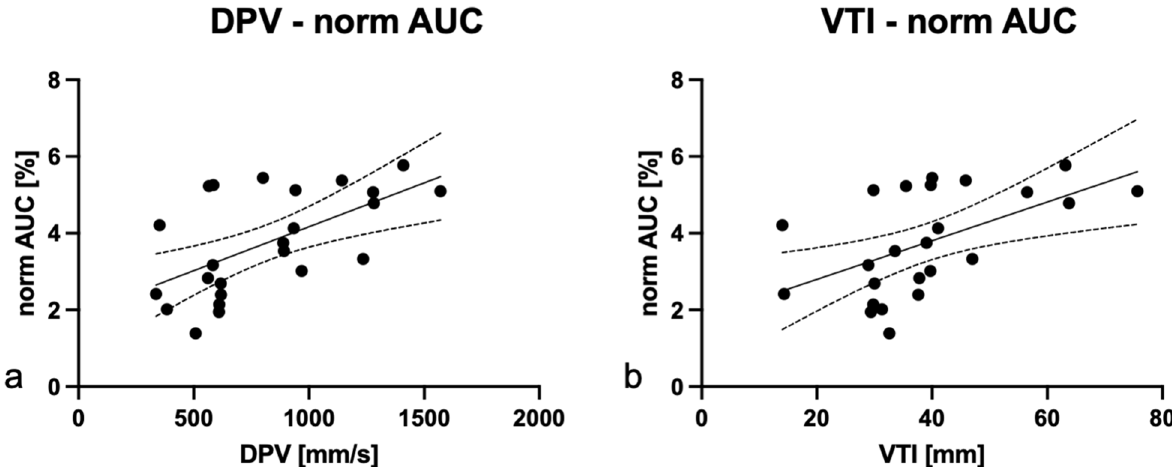
Fig. 7 Correlation plots of pulsed-wave Doppler (PWD) and myocardial contrast echocardiography (MCE) parameters. a The diastolic peak velocity (DPV) derived from PWD showed a positive correlation with the normalised area under the curve (normalised AUC) derived from MCE ( r 0.002). b The PWD-derived velocity time integral (VTI) showed a positive correlation with the normalised AUC ( r = MCE. Dotted lines represent 95% confidence